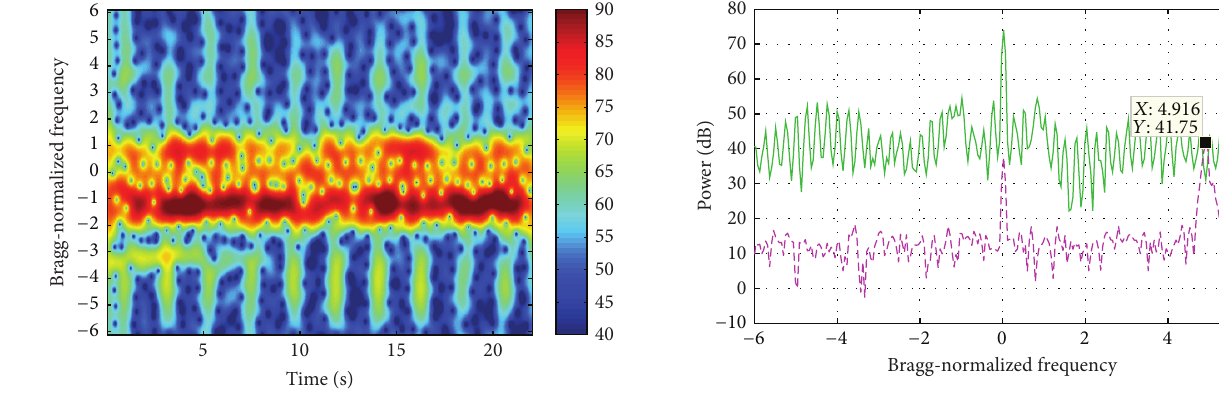
Figure 13: Time-frequency spectrogram of sum signal.